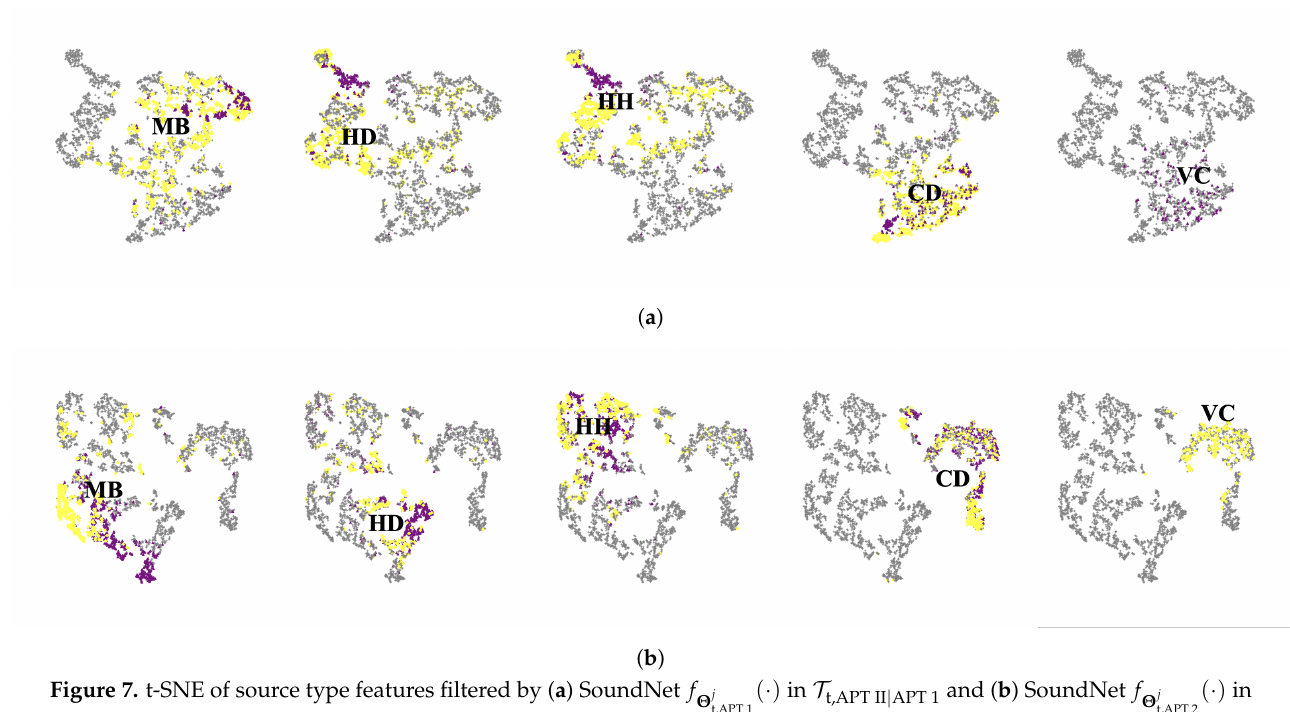
Figure 7. t-SNE of source type features filtered by ( a ) SoundNet f Θ j T t,APT I | APT 2 . The symbols in purple and those in yellow represent t-SNE of learned and unlearned signals, respectively, for a single selected source type. In addition, those in gray represent the other source types.